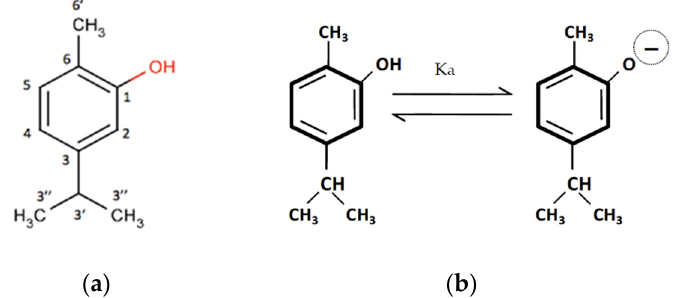
Figure 2. ( a ) Structure of carvacrol with H-atoms. ( b ) Carvacrol dissociation